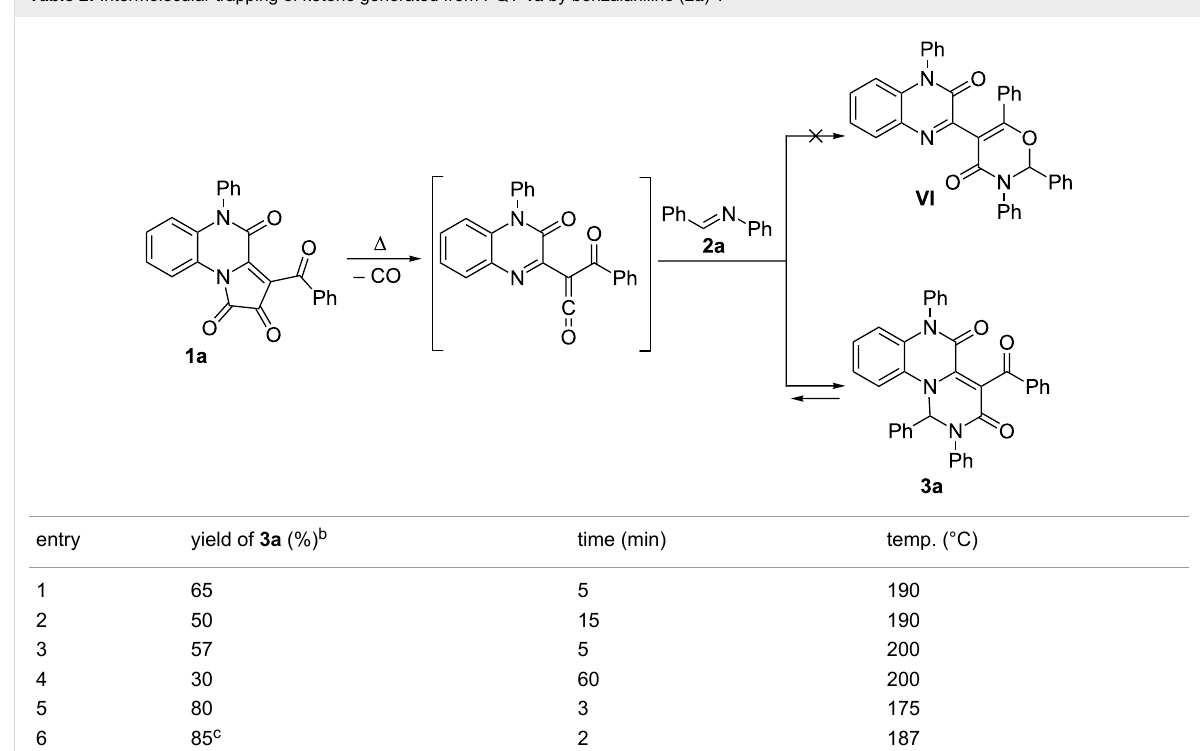
Table 2: Intermolecular trapping of ketene generated from PQT 1a by benzalaniline ( 2a ) a .